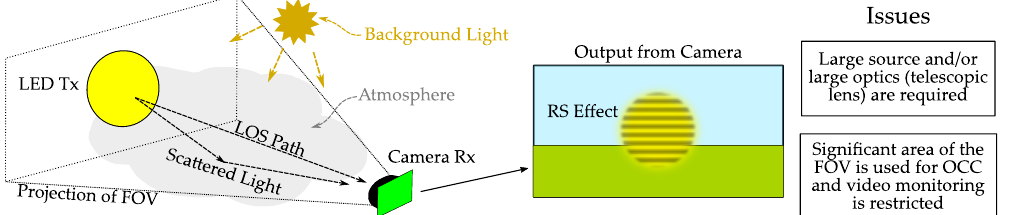
Figure 1. Diagram of the implementation of optical camera communication (OCC) using rolling shutter (RS) techniques in outdoor scenarios and the inherent issues associated with field-of-view (FOV) use in long distance